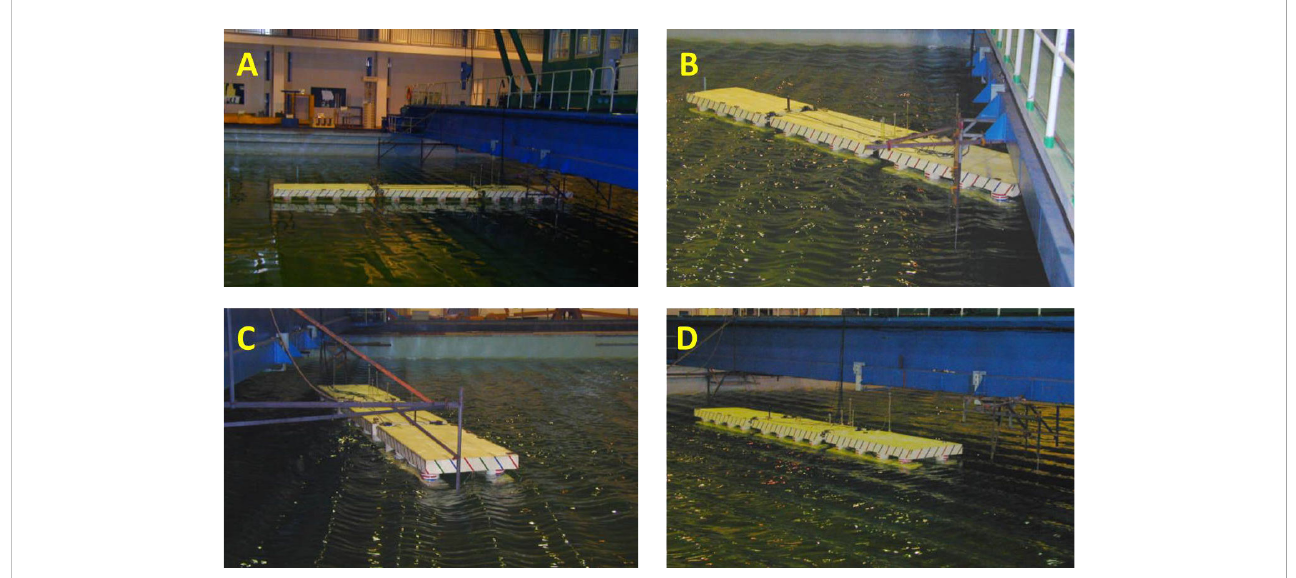
FIGURE 17 Wave incident directions for CP-VLFS (Ding, 2004 and Yu, 2004): (A) d = 0°; (B) d = 45°; (C) d = 75°; (D) d = 90°.